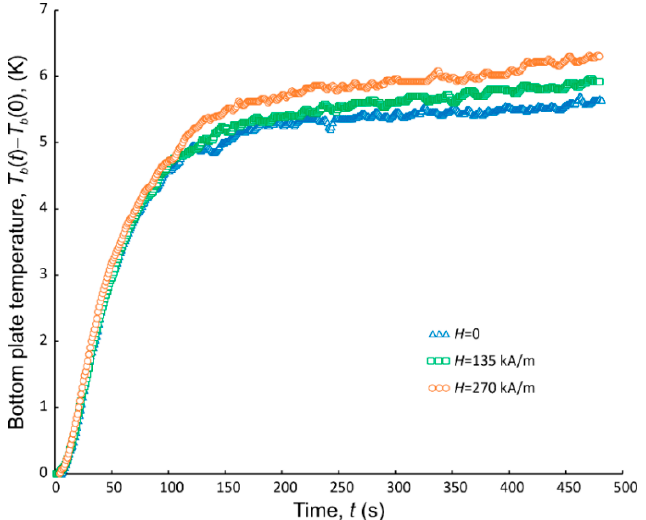
Figure 5. The temperature of the bottom (heated) aluminum plate of the cell as a function of time after heating is turned on. The results obtained in the absence and under the influence of a magnetic field are shown. Magnetochemistry 2021 , 7 , x FOR PEER REVIEW